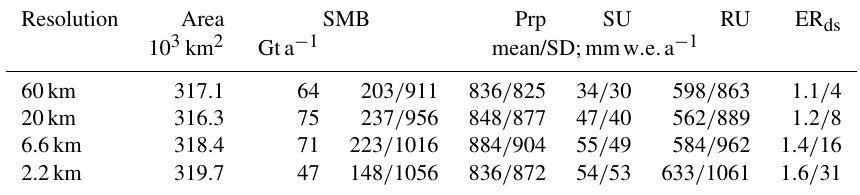
Table 2. Mean and spatial variability of the annual SMB and its components in the investigated region in south Greenland. All values are in millimetres of water equivalent per year. Additionally, spatially integrated mean SMB is given in gigatonnes per